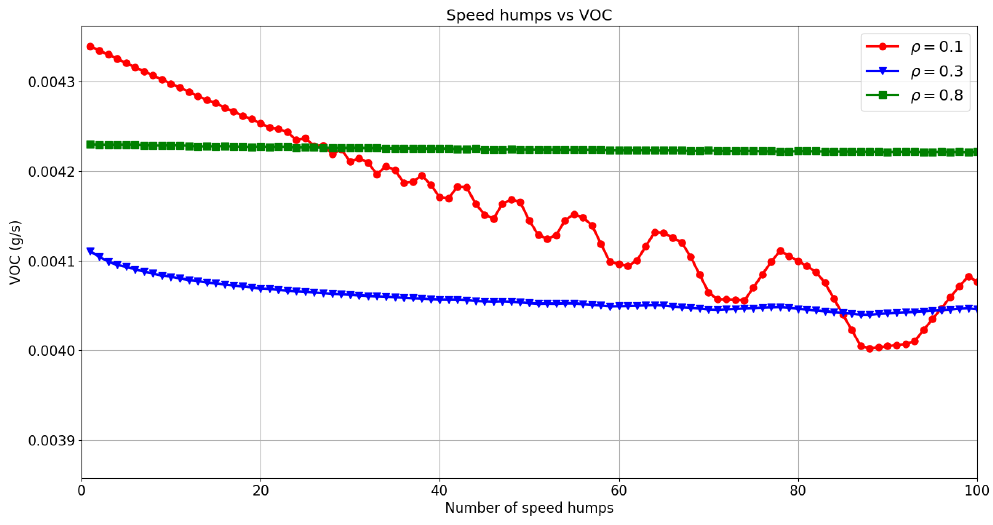
Figure 12. VOC instant emissions as a function of the number of speed